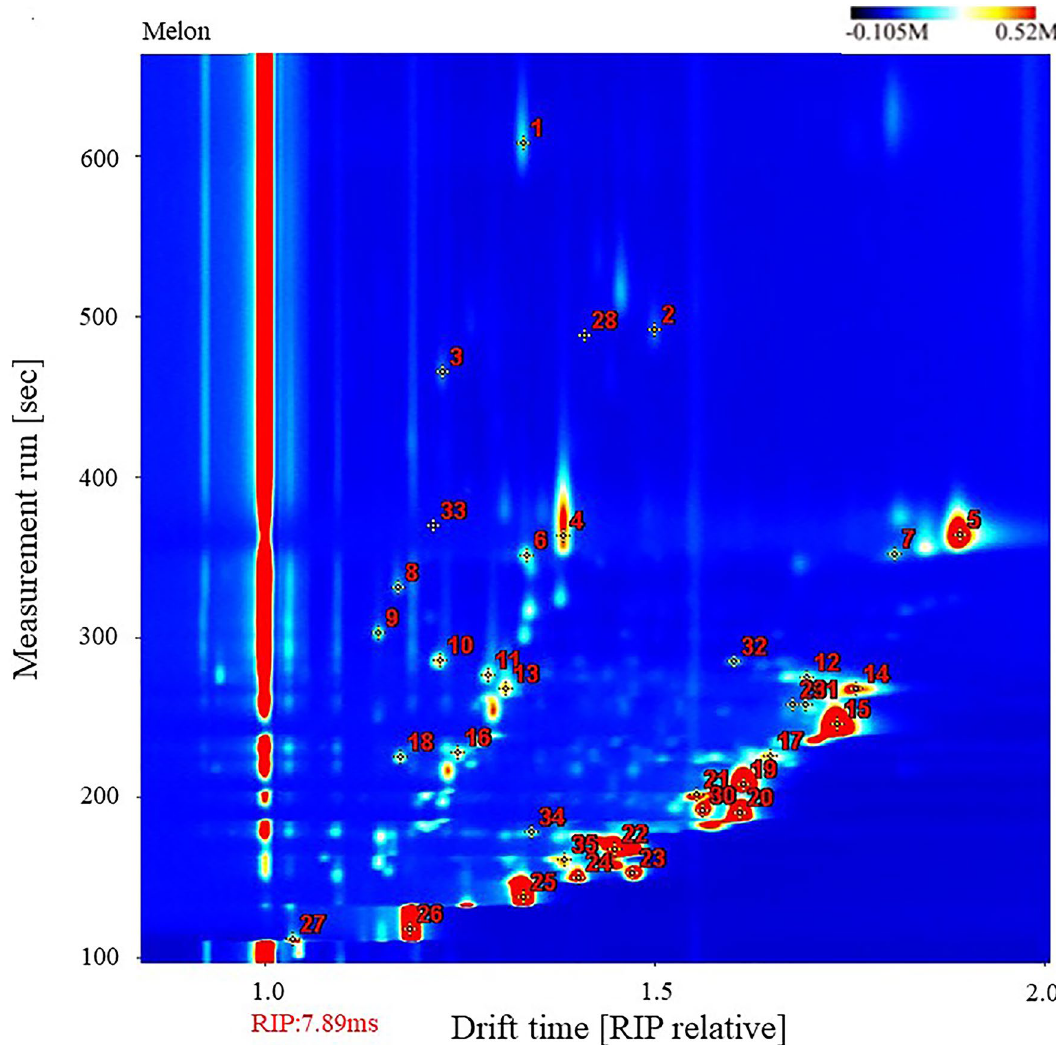
Fig. 1 Qualitative analysis of volatile organic compounds in